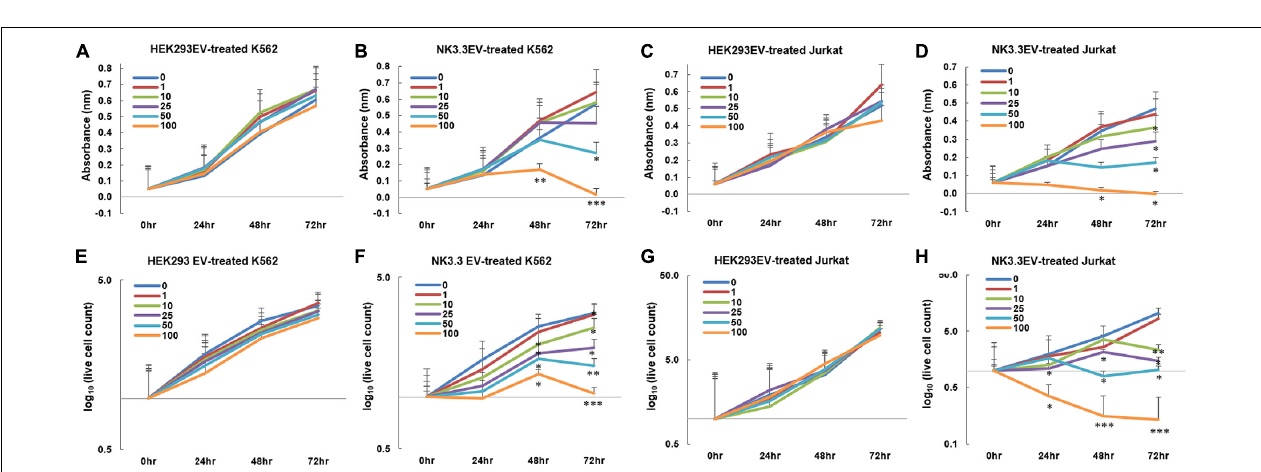
FIGURE 3 | Orientation of transmembrane proteins in NK3.3-derived EVs. (A) Twenty micrograms of NK3.3 EVs were treated with either PBS (-), Pronase (+), or Pronase + saponin (+s). Samples were then boiled in Laemmli buffer; immunoblot analysis was performed using antibodies to protein epitopes that have a vesicle membrane, cytoplasmic-facing orientation or contained within the EV lumen. (B) Conceptualization of NK3.3 EV composition depicting the localization of proteins in NK3.3-derived EVs. The majority of NKLAM and LAMP-1 proteins are positioned in this orientation.